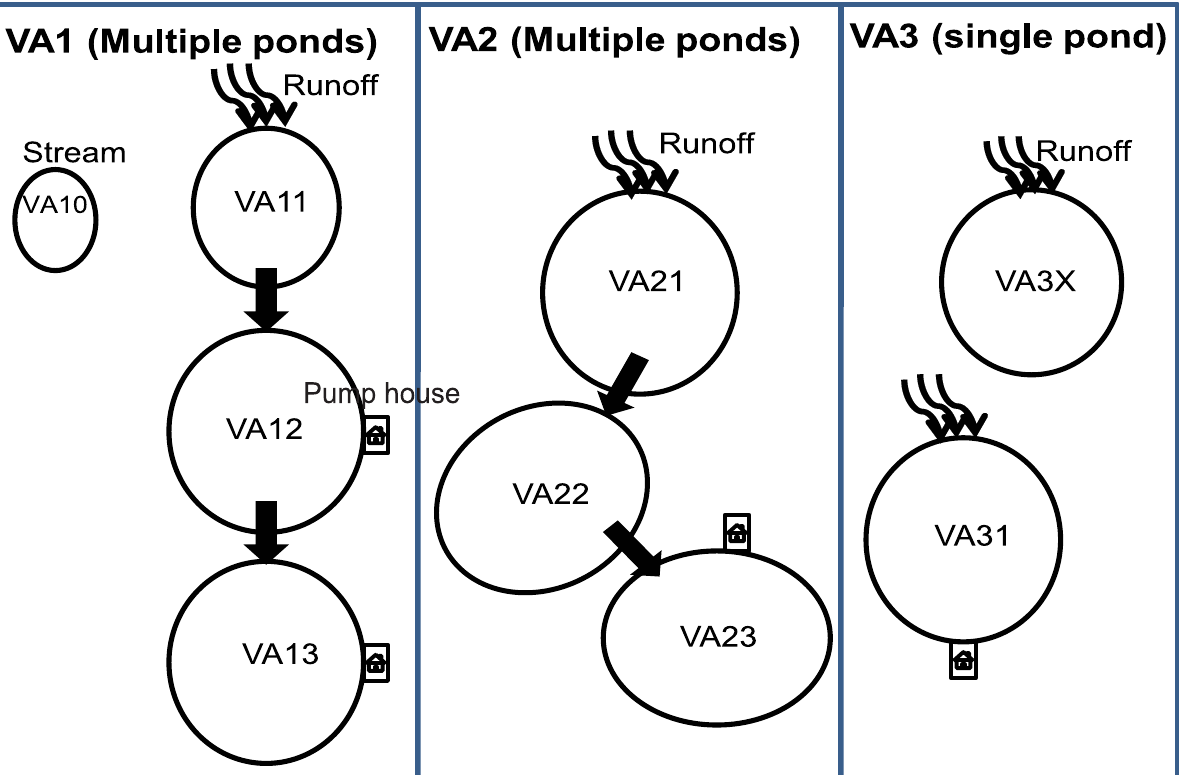
Fig 1. Recycling irrigation systemswith single or multiple reservoirsat three ornamental horticultural nurseriessurveyedin this study. Arrows illustrate water flow in reservoirs.